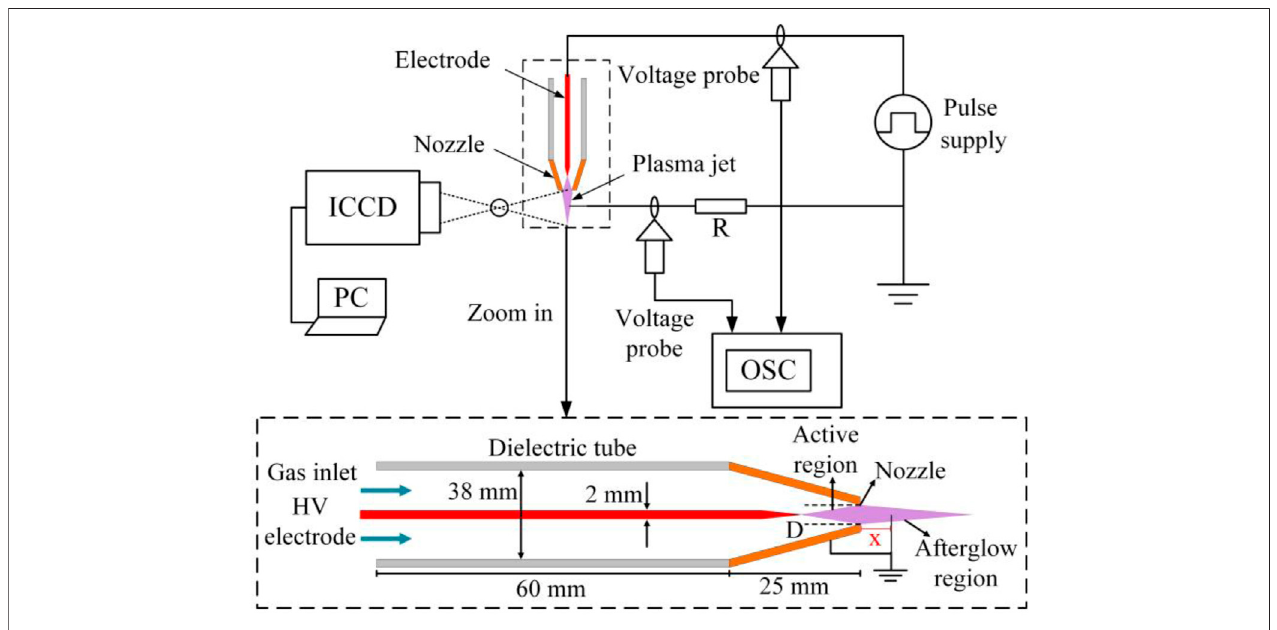
FIGURE 1 | Schematic of the air plasma jet